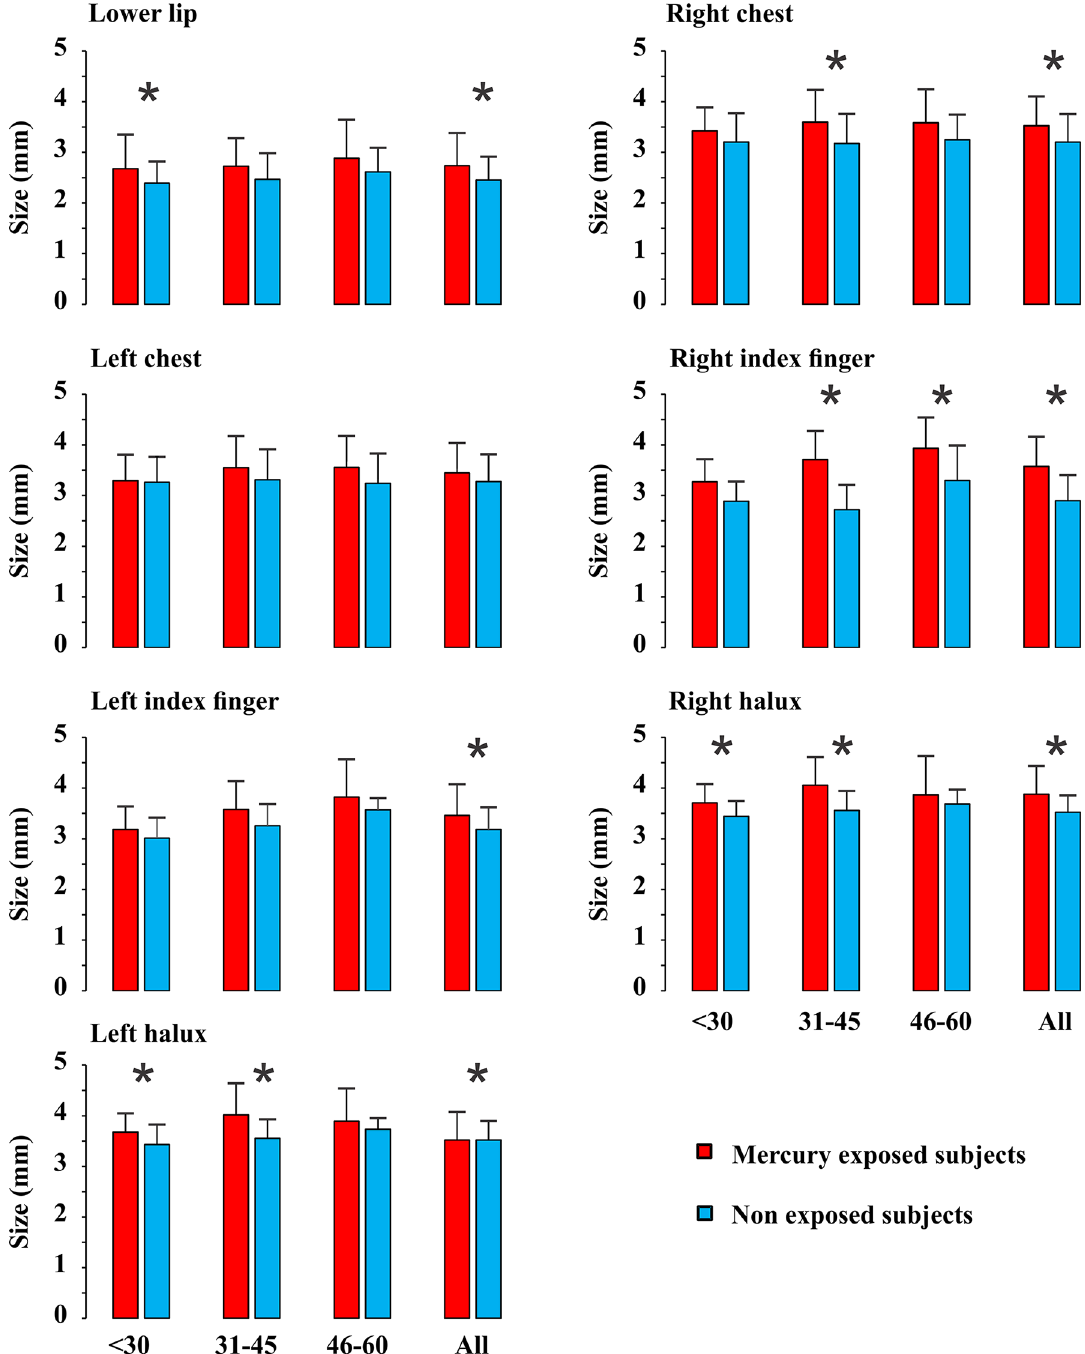
Fig 3. Tactile sensation thresholds. Measurements were performed at different body locations. Results are presented for different age groups, < 30, 31 – 45, 46 – 60 years old, and also taken together all subjects independently of age. Comparisons were made between mercury-exposed subjects and non- exposed subjects from three different Amazonian villages. Thresholds were expressed as the diameter of the filament probe and were higher at all body locations in all mercury-exposed groups when compared with non-exposed groups, but only reached statistical significance (p < 0.05) in 11 out of 21 different conditions ( * ). When data from all age groups were pooled together, differences between mercury-exposed subjects and non-exposed subjects reached the significance level in six out of seven body locations ( * ).